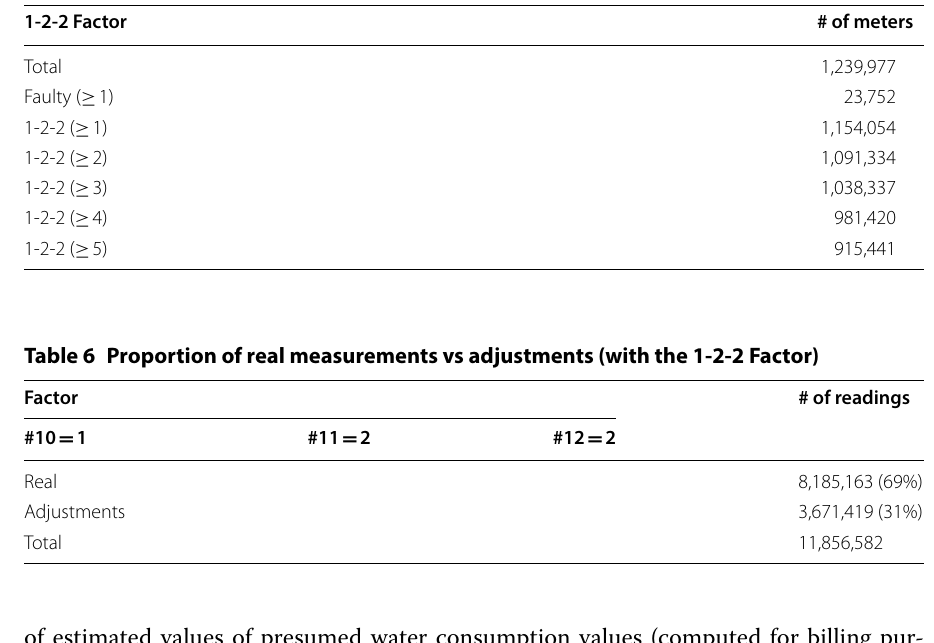
Table 5 Meters (with the 1-2-2 Factor)